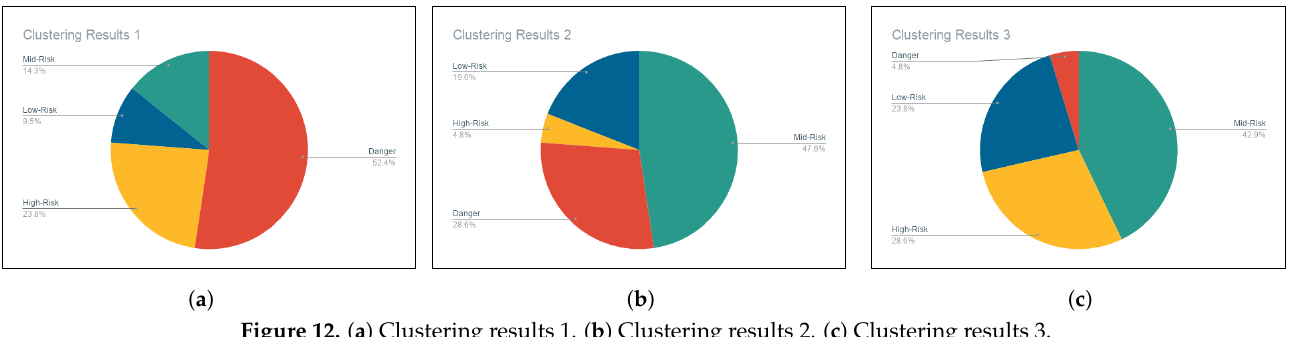
Figure 12. ( a ) Clustering results 1. ( b ) Clustering results 2. ( c ) Clustering results